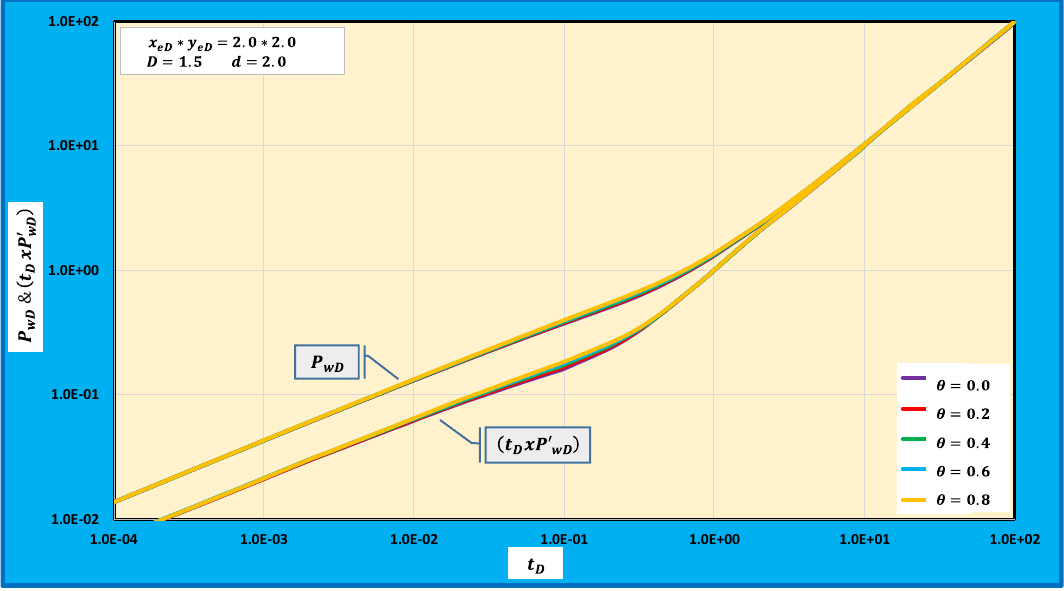
Fig. 7 Wellbore pressure and pressure derivative of different conductivity indices